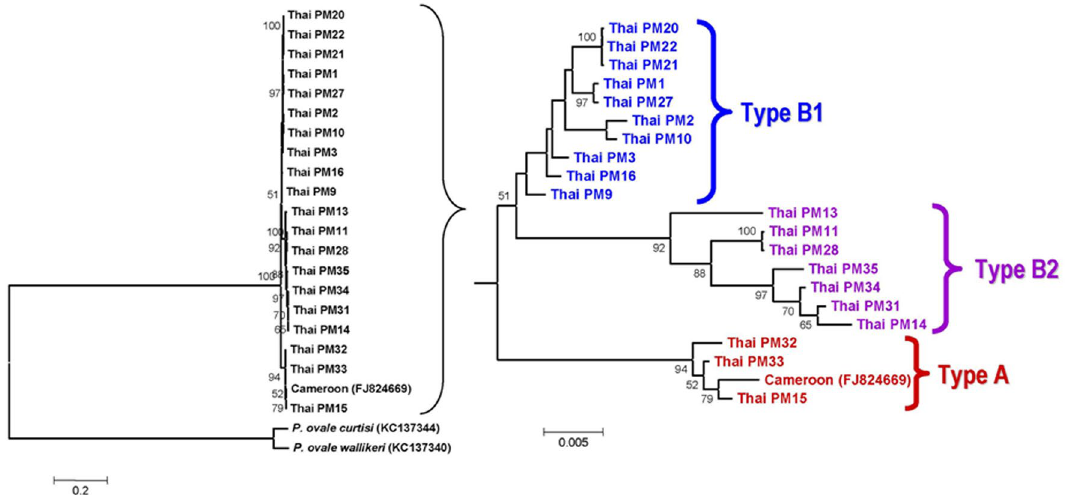
Figure 4. Maximum likelihood trees inferred from 21 distinct complete coding sequences of PmMSP1 with PocMSP1 and PowMSP1 as outgroup sequences. Numbers on the branches are the percentage of 1000 bootstrap samples supporting the branch; only values greater than 50 are shown. Types are based on repeat classification in Fig. 3. Scale bar indicates nucleotide substitution per site.